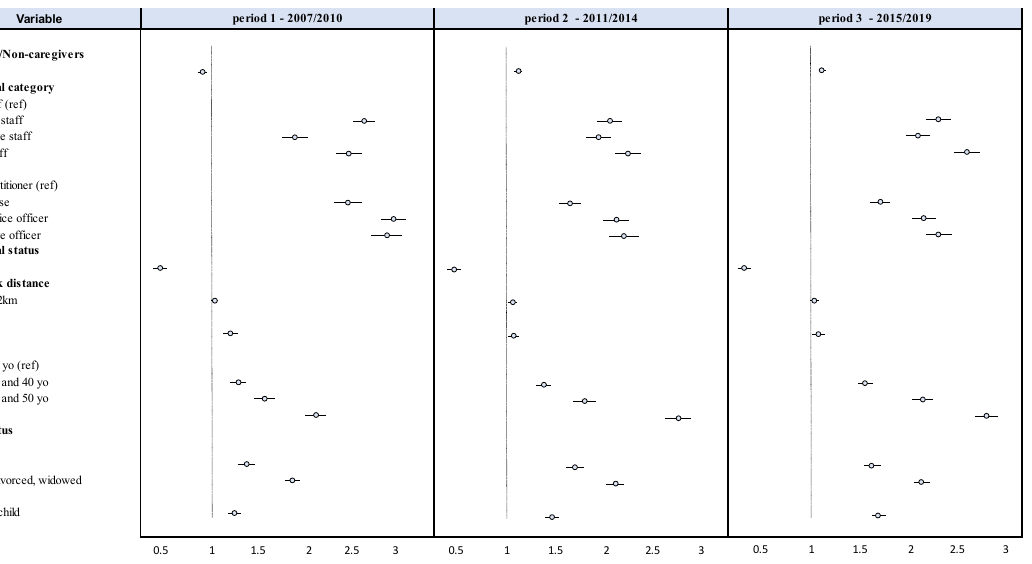
Figure 4. Forest plot of the incidence rate ratio of compressible absence risk as a function of occupa- tional and sociodemographic factors by period (zero inflated negative binomial model (ZINB)).